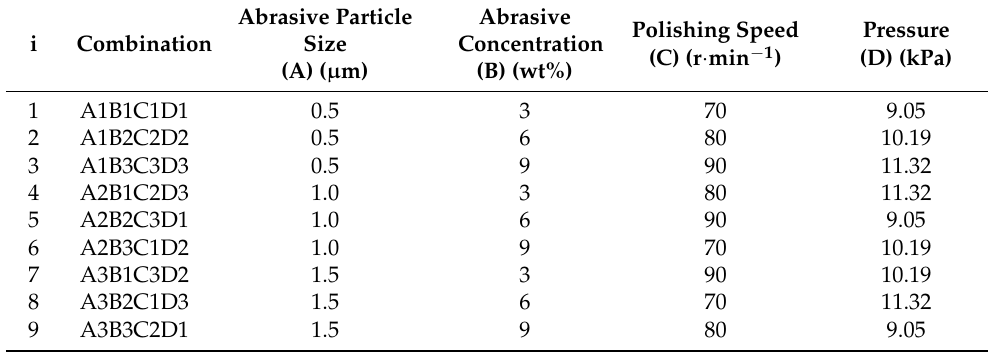
Table 3. L9(3 4 ) Orthogonal experimental.